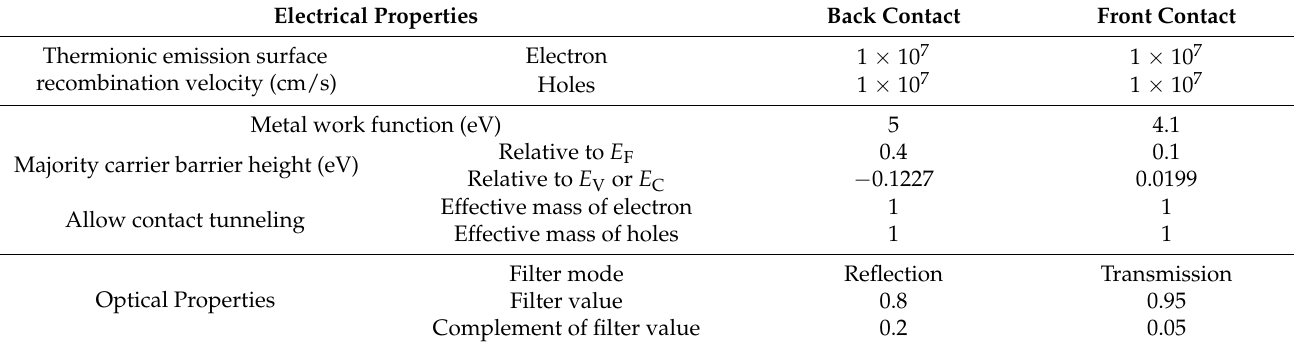
Table 2. Electrical parameters properties of back and front contact used for the metal oxide SCAPS–1D simulation.